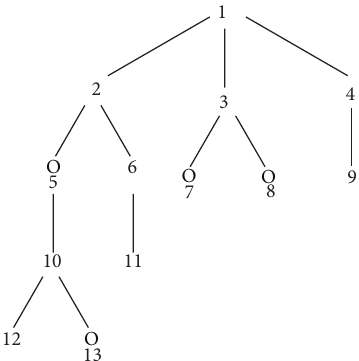
Figure 3: Graphical representation of tree graph extracted from aspirin molecule graph.